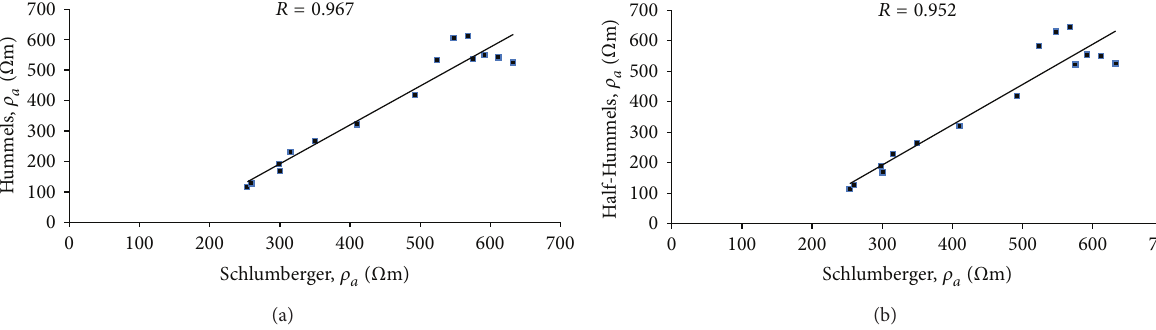
Figure 22: Statistical plot of apparent resistivity data for location 24 (augen gneiss) (a) Hummel against conventional Schlumberger (VES) and (b) “Half-Hummel” against conventional Schlumberger